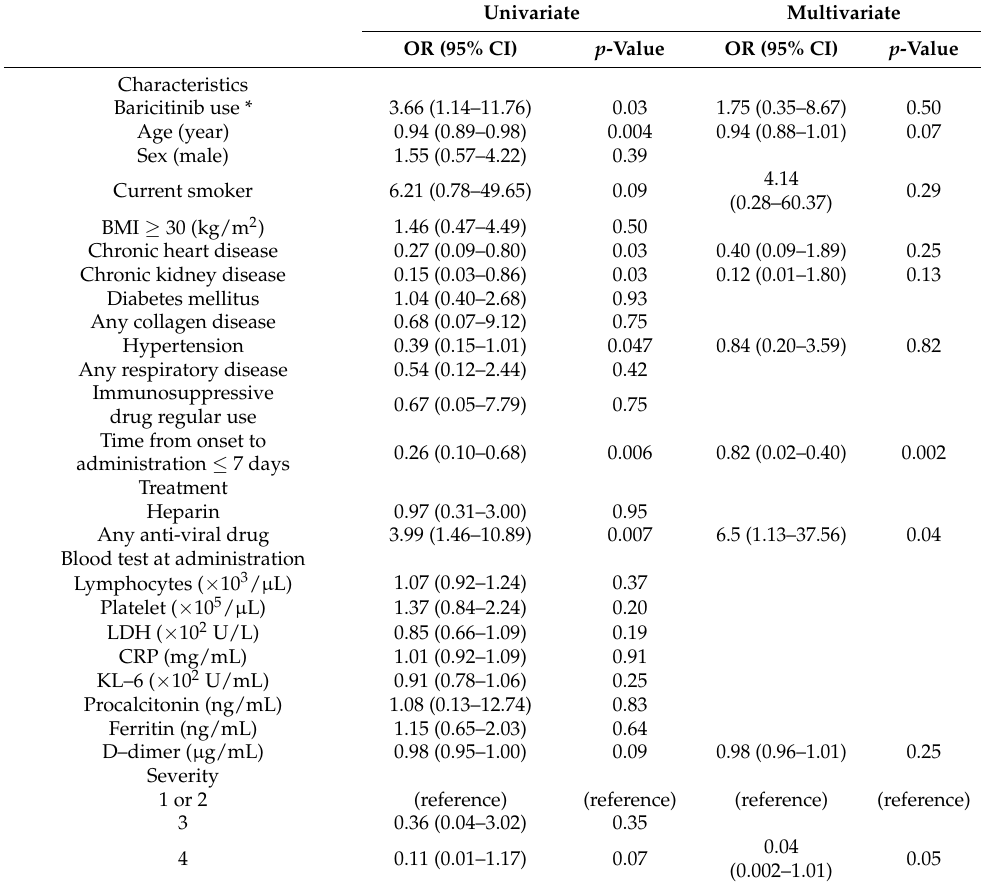
Table 3. Predicting factors for respiratory improvement within 28 days from administration of tocilizumab or baricitinib